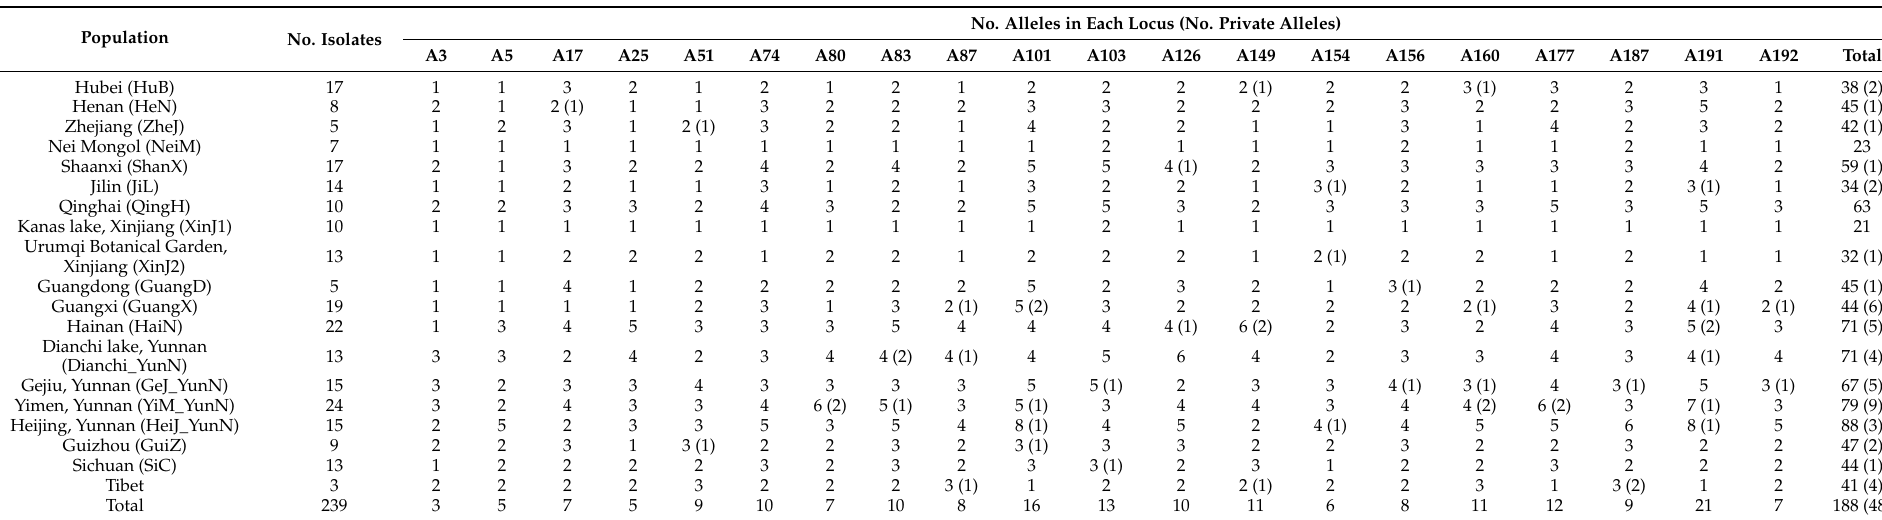
Table 1. STR allele distributions within and among 19 geographic populations of A. oligospora for each of the 20 STR